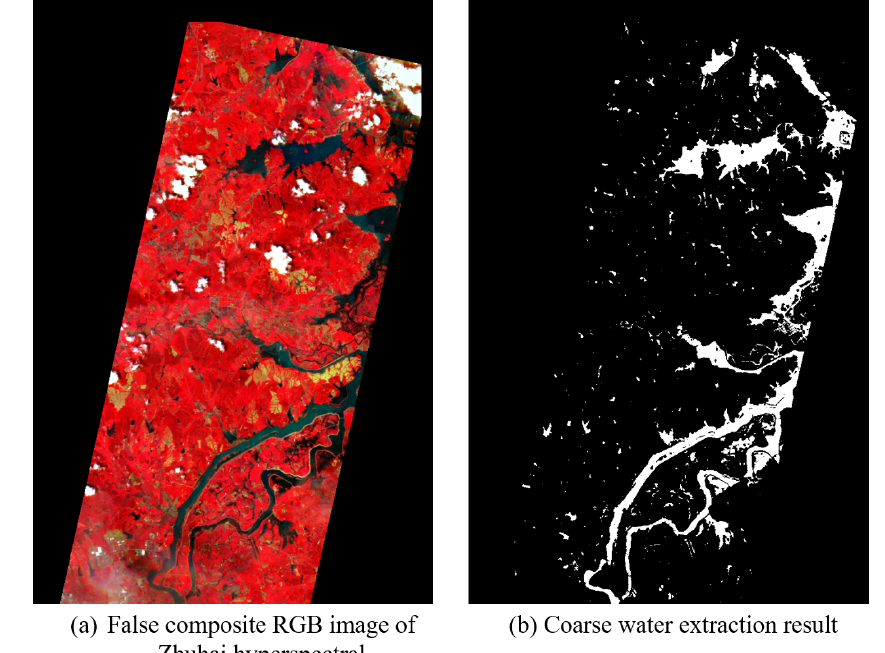
Figure 10. Coarse water extraction of Zhuhai-1